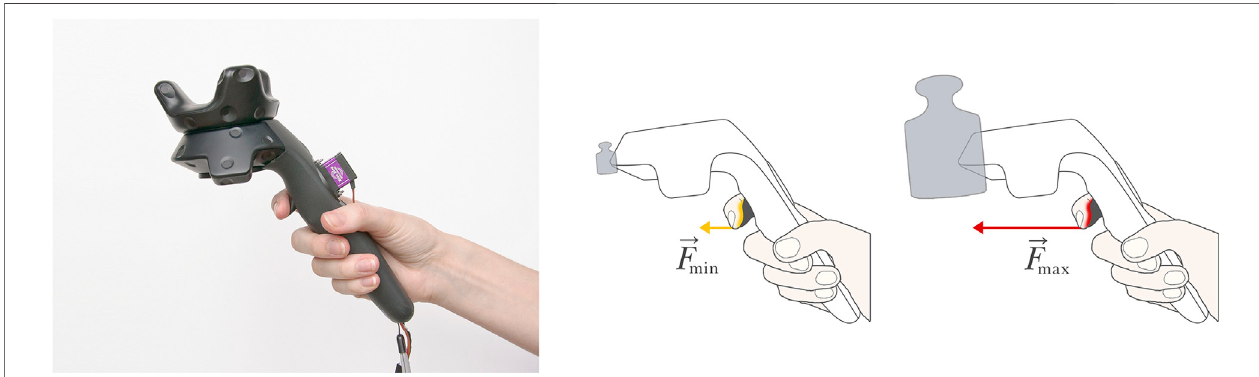
FIGURE1|(left) OurhapticcontrollerTriggermusclesimulatestheweightofvirtualobjectsinVRthroughadaptingthetriggerresistance.Thespringmechanismfor adynamicadjustmentisbuiltintothecasingofanHTCVivecontroller.AnHTCVivetrackerismountedtothetoptoenablespatialtracking. (right) Triggermuscleallowsa continuous regulation of the trigger resistance according to the weight of the grabbed virtual object.